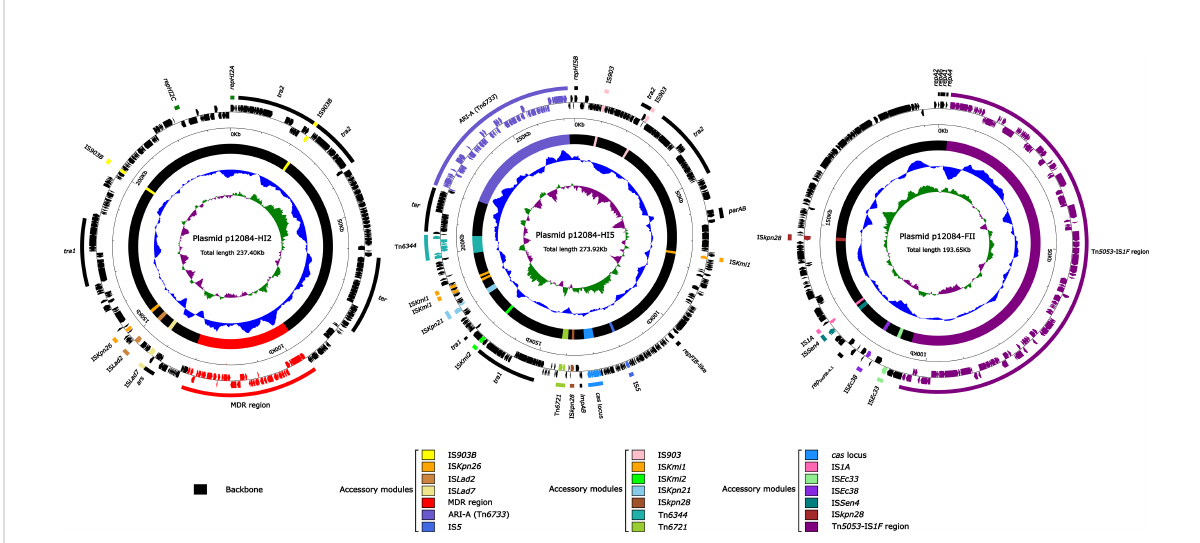
FIGURE 1 Schematic maps of p12084-HI2, p12084-HI5, and p12084-FII plasmids. Genes are denoted by arrows, and the backbone and accessory module regions are highlighted in black and color, respectively; The innermost circle presents GC-skew [(G-C)/(G+C)], with a window size of 500 bp and a step size of 20 bp. Inward indicates the relative content G > C, and outward indicates the relative content G < C; The next-to-innermost circle presents G and C content. Inward indicates below average G and C content, and outward indicates above average G and C content; The outermost circle shows the arrangement of genes, with genes forward and reverse in clockwise and counterclockwise directions,